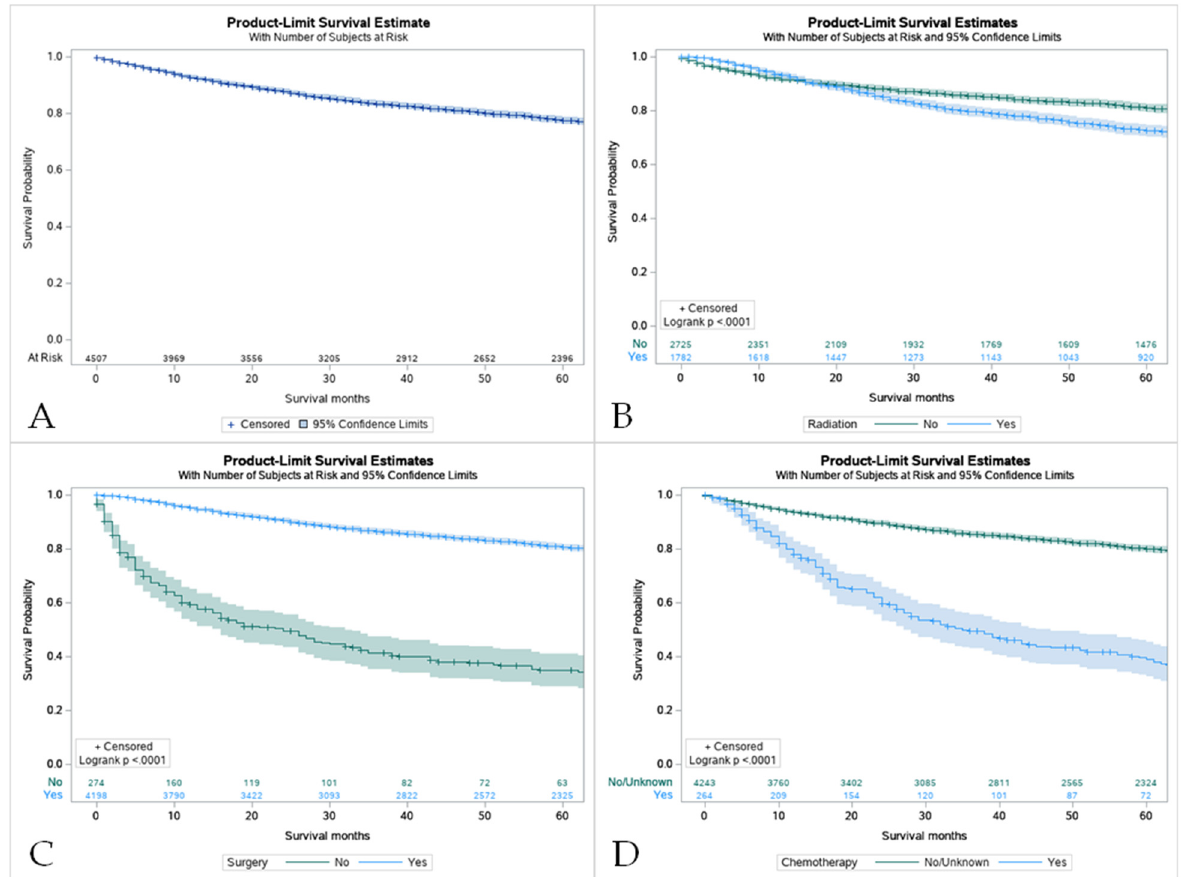
Figure 4. Kaplan Meier graphs displaying comparative survival analysis of patients with mucoepi- dermoid carcinoma (MEC) over the span of 60 months (5 years) by ( A ) Overall survival, ( B ) Survival with radiation therapy, ( C ) Survival with surgery, and ( D ) Survival with chemotherapy. Patients with MEC who did not receive radiation or chemotherapy had higher 5-year survival compared to patients who did receive one or the other. Comparatively, patients who underwent surgery had a statistically significant higher 5-year survival compared to those who did not ( p < 0.05).